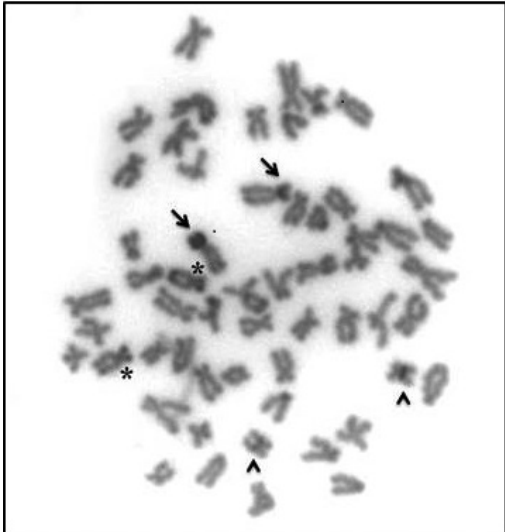
Figure 3. Somatic metaphase of Phractocephalus hemioliopterus after C-banding. Arrowheads indicate the chromosome pair with interstitial heterochromatin; arrows indicate the NOR-bearing chromosome and asterisks indicate the chromosomes with heterochromatin blocks in both terminal